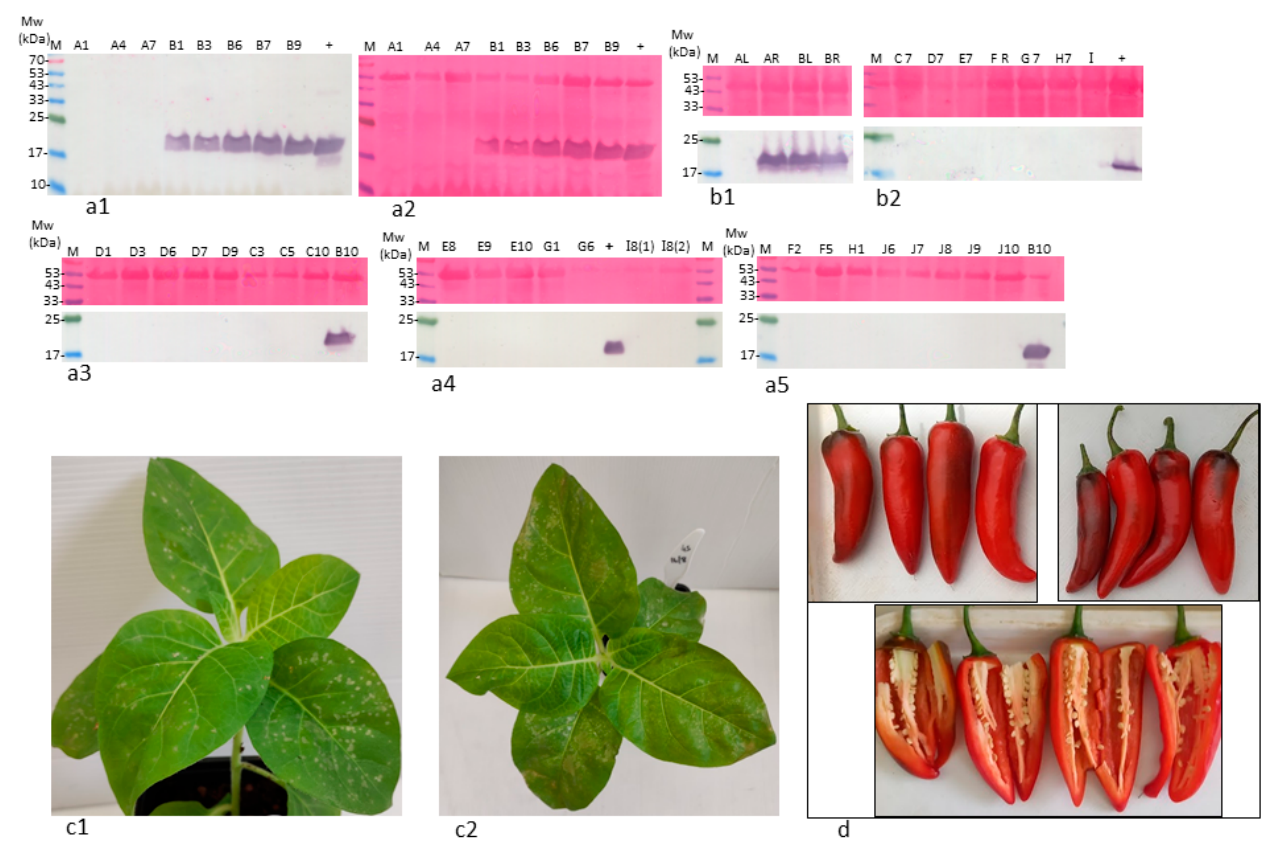
Figure 3. ToBRFV transiently infected leaves of UD varieties and L 1 Lapid plants but stably infected L 0 cv. 6210 plants. ( a1 – a5 ) Western blot analyses (and ponceau-s staining) showed that excluding L 0 cv. 6210 plants, at 75 dpi, leaves of all UD varieties and L 1 Lapid plants were not ToBRFV infected. ( b1 , b2 ) Western blot analyses (and ponceau-s staining) confirmed ToBRFV seed infection only in fruits of L 0 cv. 6210 plants (BL, BR) and in root-inoculated cv. 10875 (AR). ( c1 , c2 ) Necrotic local lesions developed on N. tabacum cv. Xanthi inoculated with fruit or seed extract of ToBRFV-infected L 0 cv. 6210 plants (leaf-inoculated). ( d ) Fruits of L 0 cv. 6210 plants were asymptomatic ca. 12 months postinoculation. A–J, all plants of UD varieties, L 1 Lapid (J) and L 0 cv. 6210 (B) were ToBRFV leaf infected at 19 dpi. Numbers indicate the specific plant between 1 and 10 (see Materials and Methods): A, cv. 10875; B, L 0 cv. 6210 plants; L, leaf-inoculated; R, root-inoculated; M, molecular size marker; (+) positive control from tomato